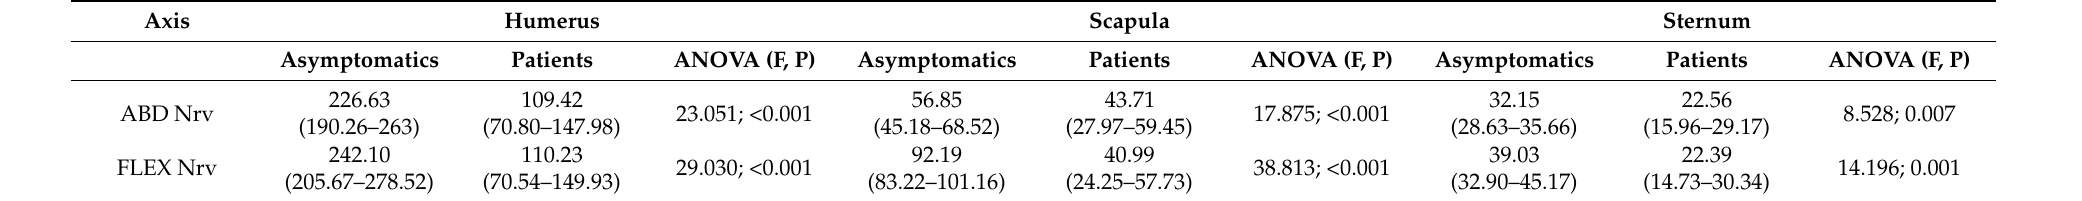
Table 3. Mean (95% CI) velocity ( ◦ /s) from the resultant vector in abduction and flexion movement.